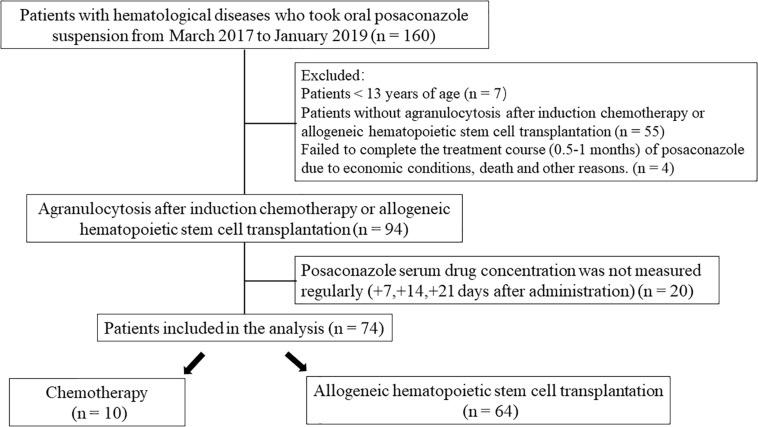
Flow chart of the study.